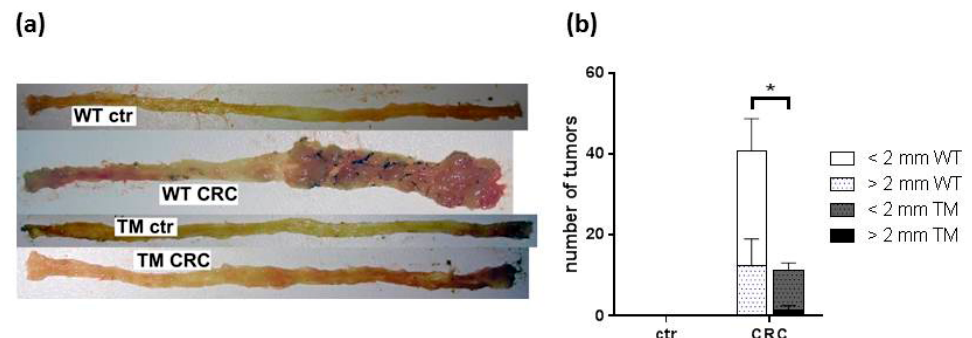
Figure 1. ( a ) Schematic representation of the schedule of acetoxymethan/dextran sulfate sodium (AOM/DSS) application. Control mice were treated with AOM only, but no DSS was applied (not shown). ( b ) Mice of either wild type (WT) or H 4 R − / − (TM) genotype were treated either with AOM/DSS